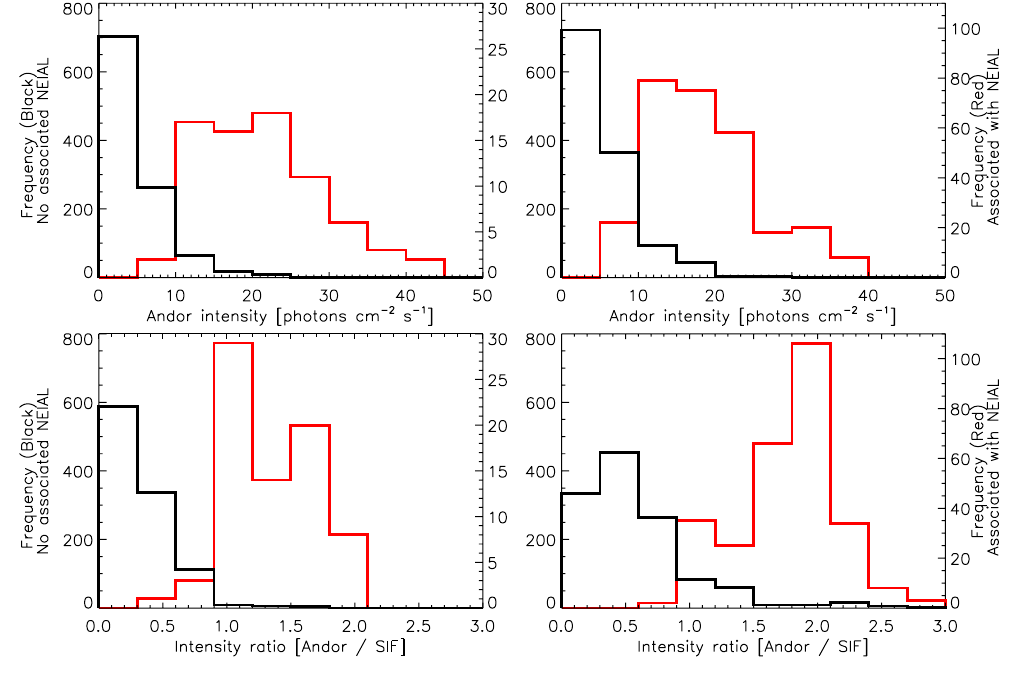
Fig. 8. As Fig. 7 for the 15min intervals starting at 09:30UT (left column) and 09:45UT (right